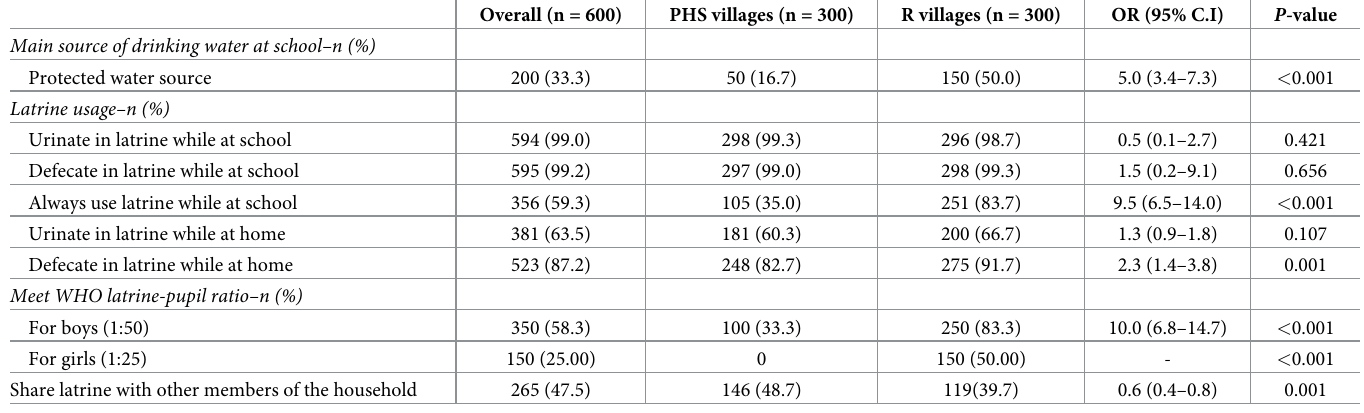
Table 9. Univariate logistic regression on the nature of water, sanitation and hygiene in study schools from school children. Overall (n =